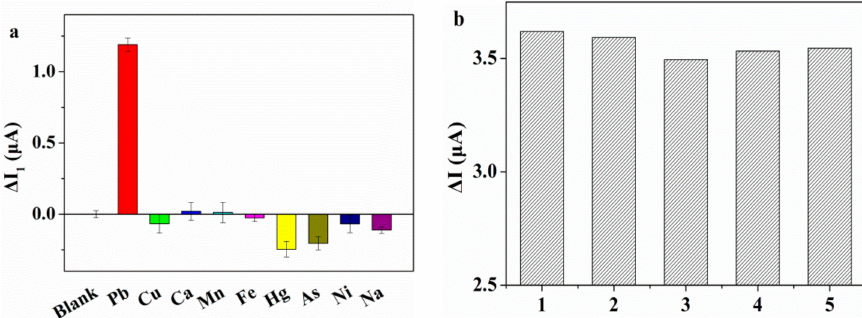
Figure 5. ( a ) Specificity of the aptasensor for Pb 2+ , ( b ) independent detection of the Pb 2+ .